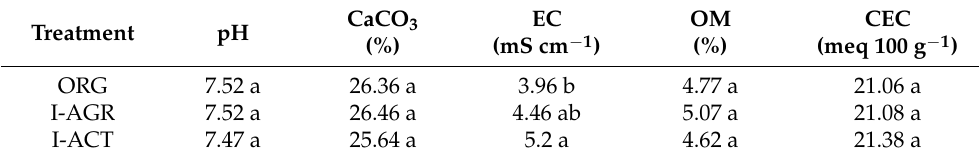
Table 9. Effects of cultivation management on soil properties.